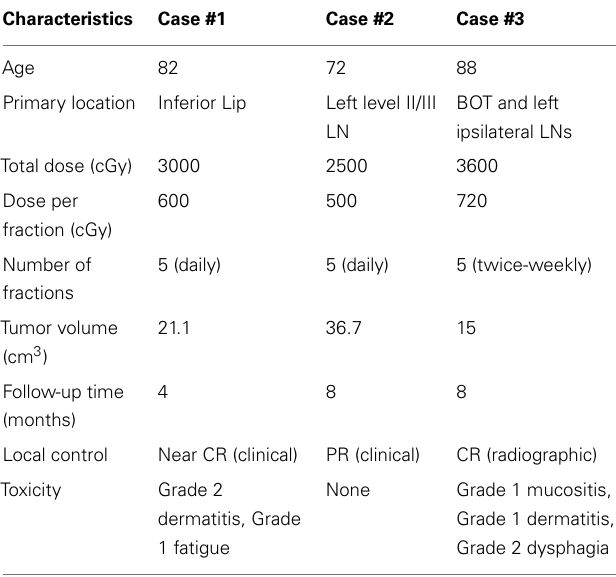
Frontiers in Oncology | Radiation